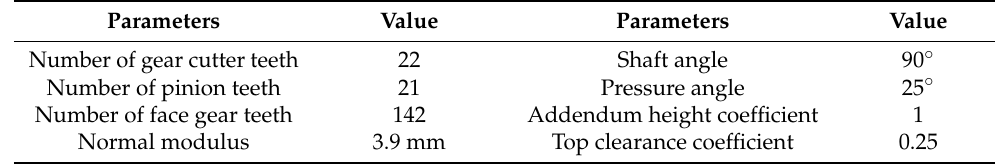
Table 1. Main parameters of the concentric face gear split-torque transmission system.